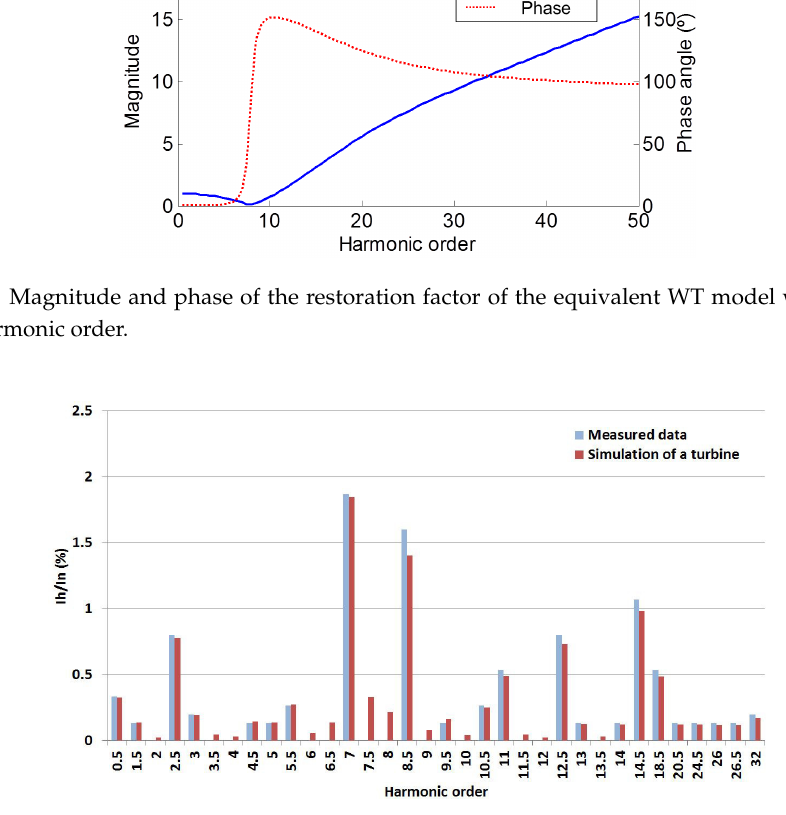
Figure 6. Comparison between the measured data and the simulation result of the single